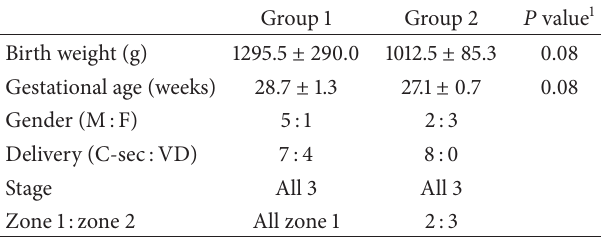
Table 1: Demographics of infants in Group 1 and Group 2.